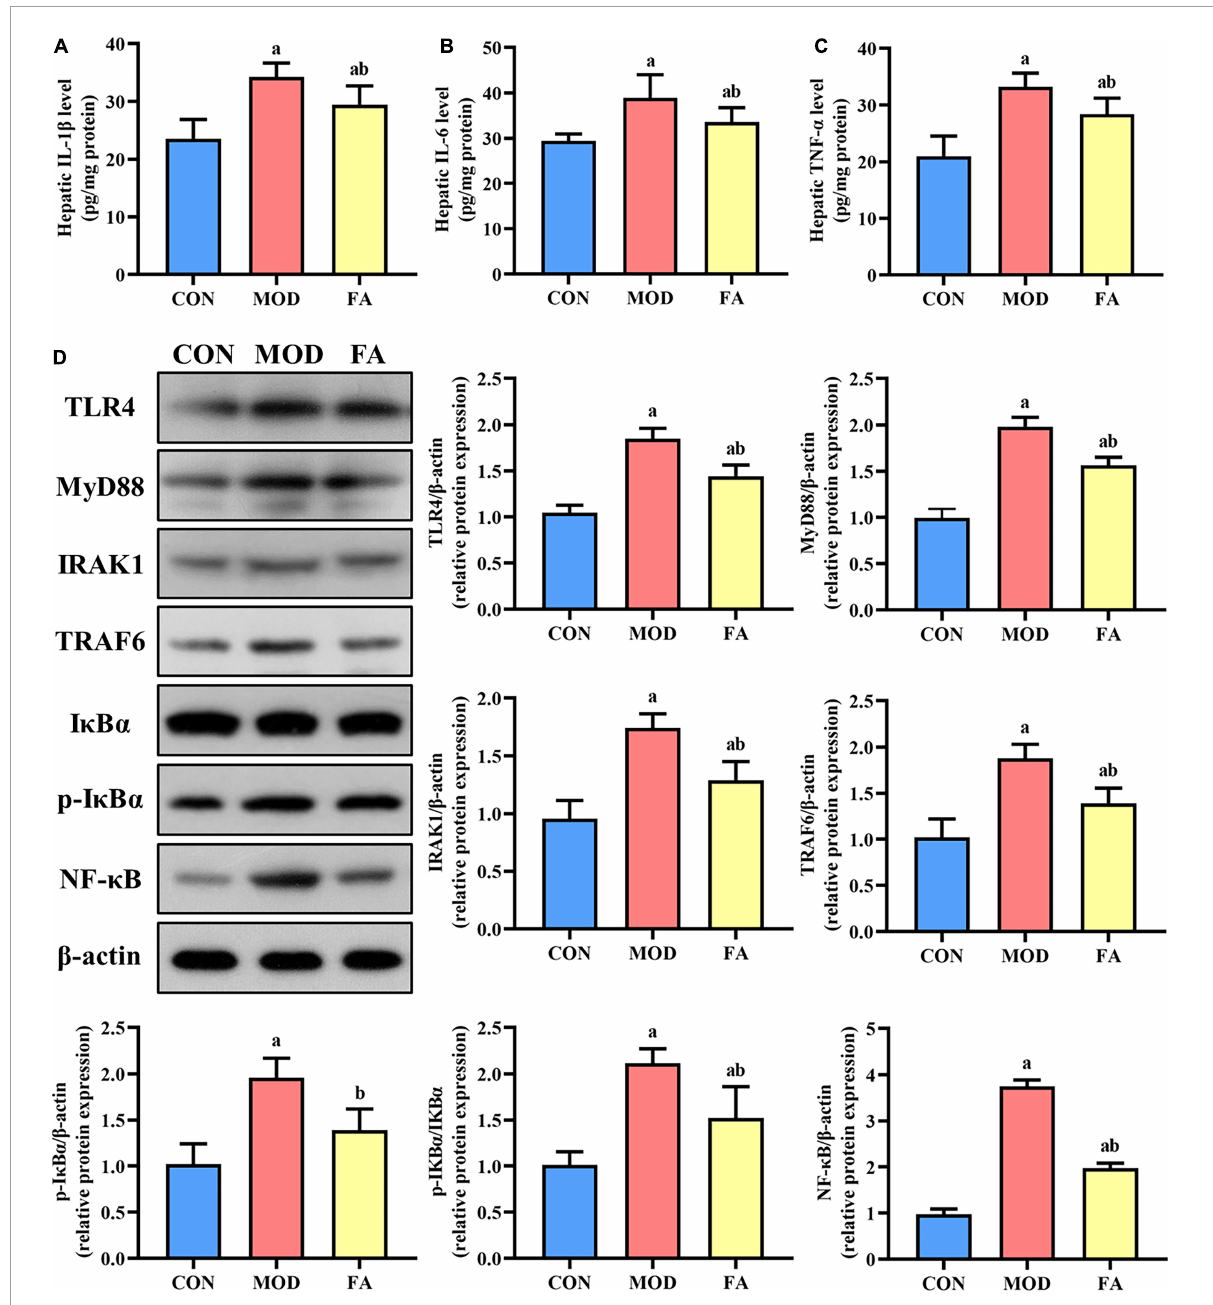
FIGURE4 Effects of folic acid on hepatic inflammatory cytokines and the expression levels of TLR4 signaling pathway proteins. (A) Hepatic IL-1 β level; (B) hepatic IL-6 level; (C) hepatic TNF- α level; (D) representative Western blot of TLR4, MyD88, IRAK1, TRAF6, I κ B α , p-I κ B α , and NF- κ B protein levels relative to the expression of β -actin ( n = 3/group). Data are presented as mean ± SD ( n = 8/group). a p < 0.05 compared with the CON group; b p < 0.05 compared with the MOD